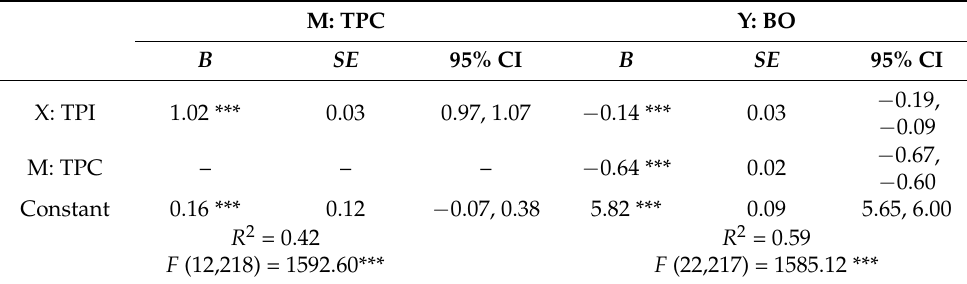
Table 3. Results of mediation analysis of teacher psychological